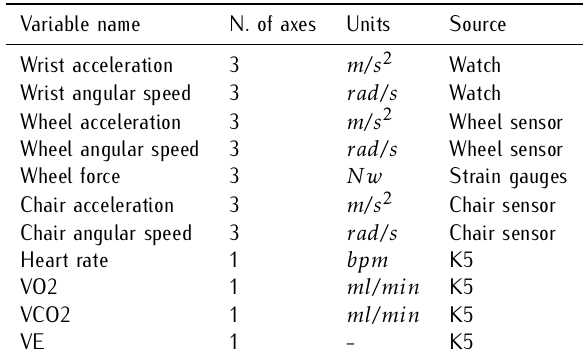
Table 1. List of the most important available variables. The strain gauges were mounted on the wheel. The Chair sensor was mounted on the frame of the